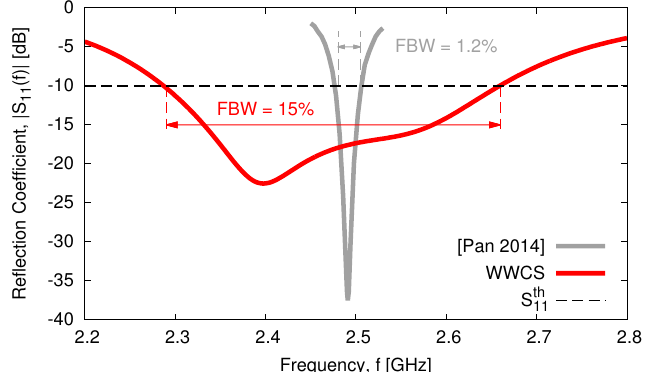
Figure 4. Numerical assessment ( [ f min , f max ] = [ 2.3, 2.6 ] [GHz])—behavior of the reflection coefficient at the antenna input port,